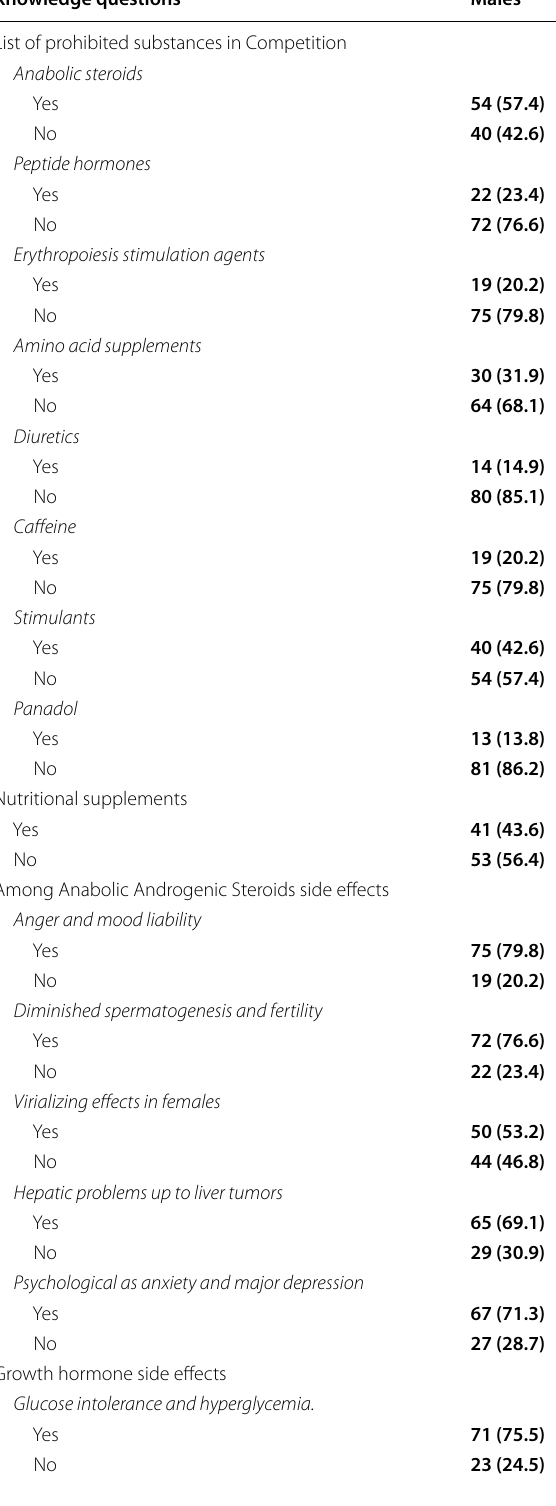
Table 3 Knowledge of PESs among participants. The frequency of correct and incorrect answers for questions 5–9 in the knowledge section of the questionnaire for each sex (total